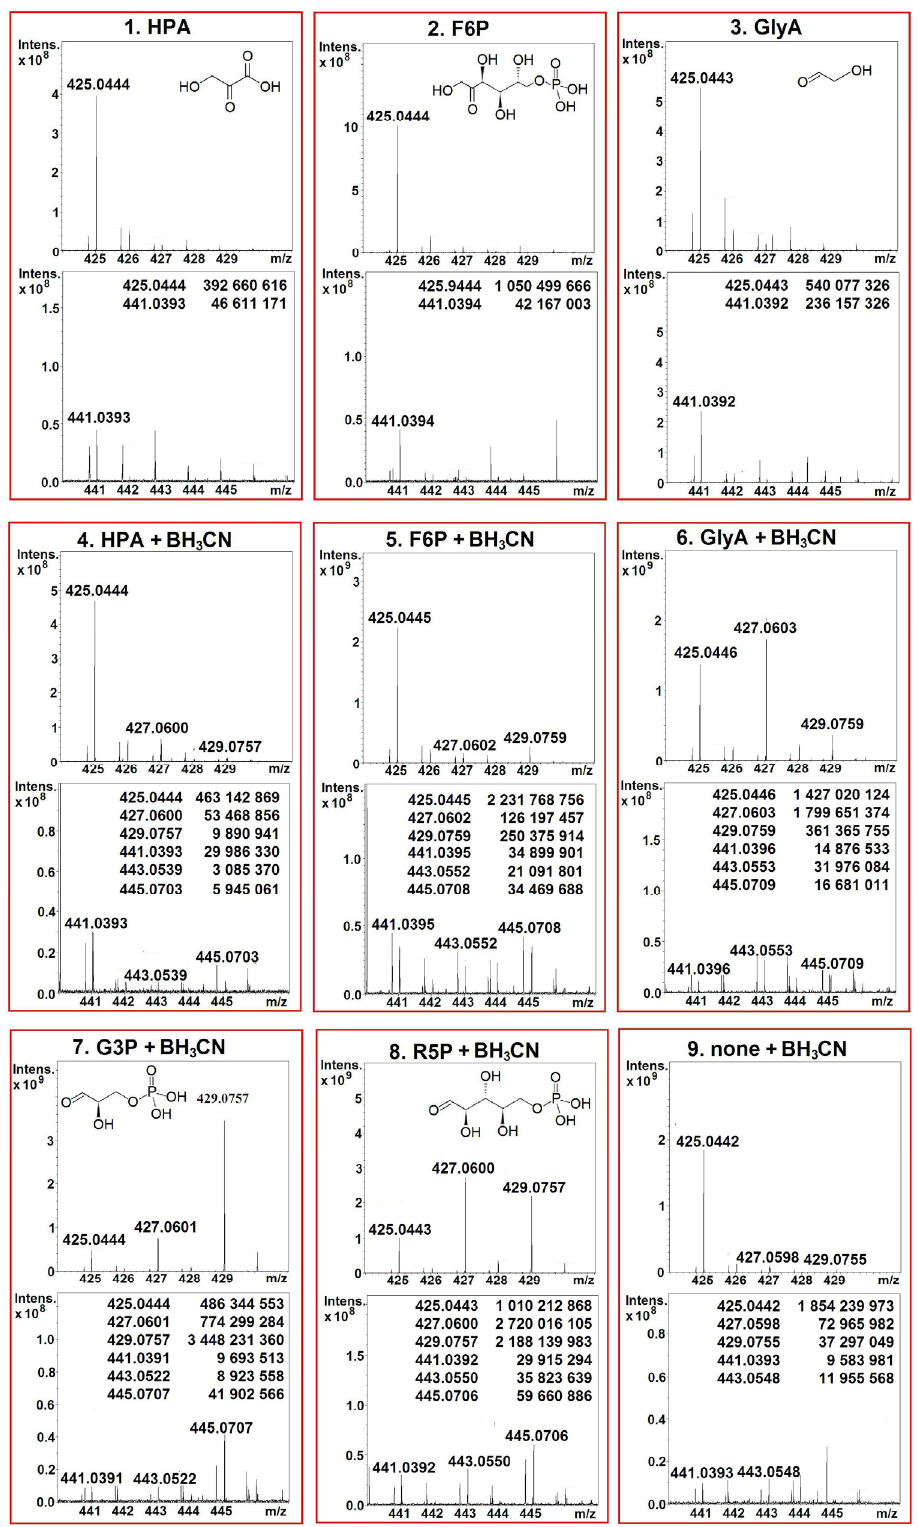
Figure 2. Typical MS spectra of ThDP and its intermediates after incubation of holoTK with donor substrates without ( 1 – 3 ) and with ( 4 – 6 ) NaBH 3 CN; with acceptor substrates ( 7 , 8 ) and without substrates ( 9 ) with NaBH 3 CN, at m / z intervals of 424–430 and 440–446. Inserts—absolute intensities of m / z 425 and 441 and its hydrated forms. Data from Apex